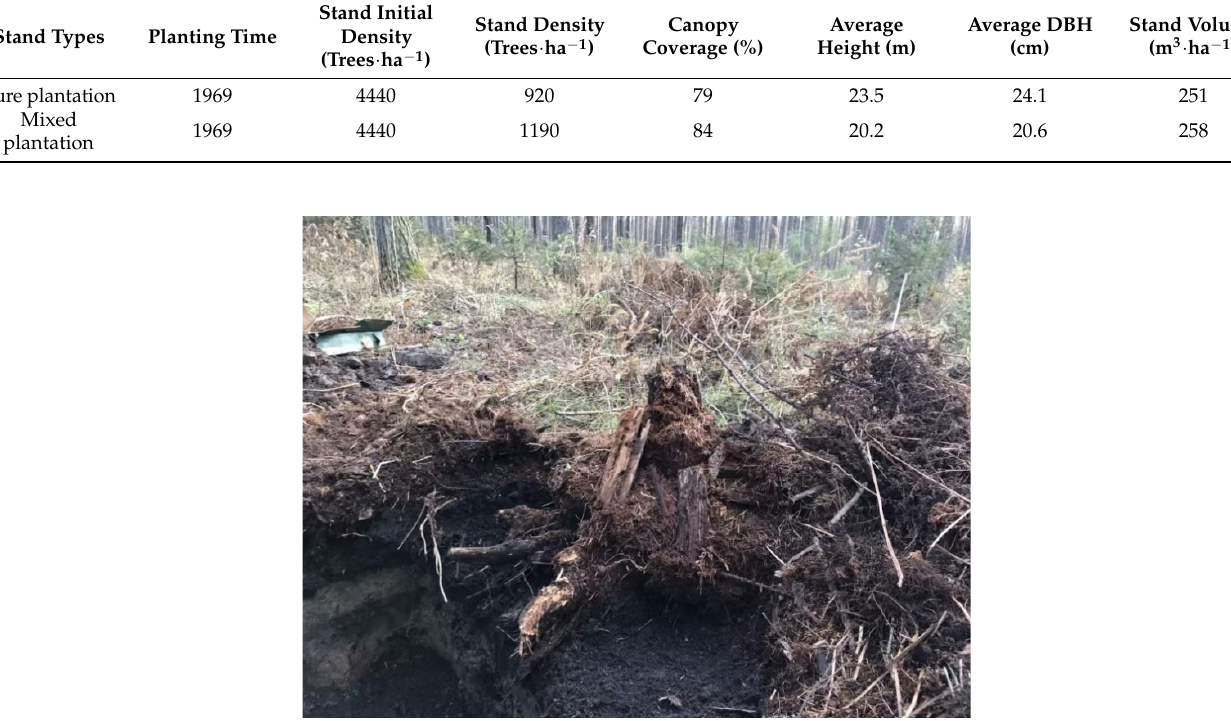
Figure 2. Larch stump and coarse root of the decay state selected in the experiment.